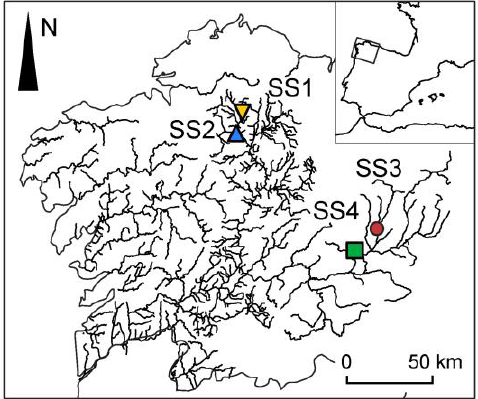
Figure 1. Locations of the four sampling stations in NW Spain.